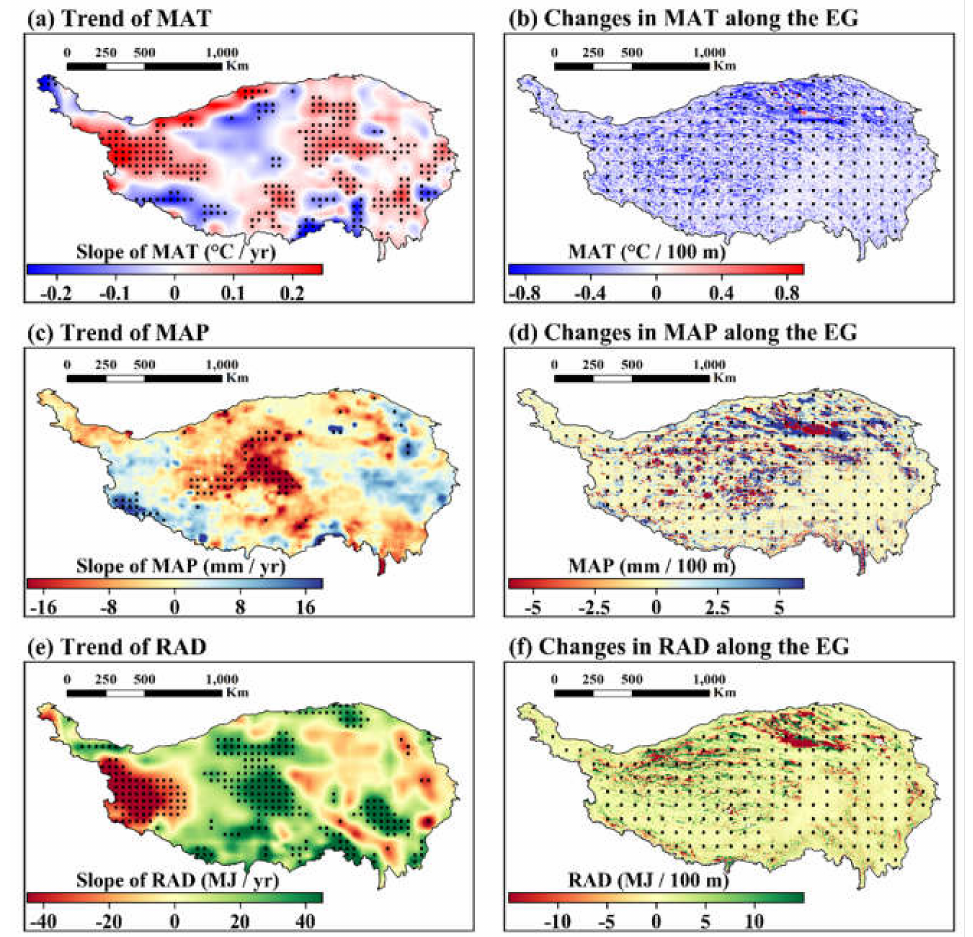
Figure 4. Spatial patterns of the climate trend and their changes along elevation gradients in the QTP from 2001 to 2016. ( a , c , e ) Trend of MAT, MAP, and MAR, respectively. ( b , d , f ) Changes in MAT, MAP, and MAR along the elevation gradient, respectively. The regions with black dots indicate that the trend is statistically significant at the 0.05